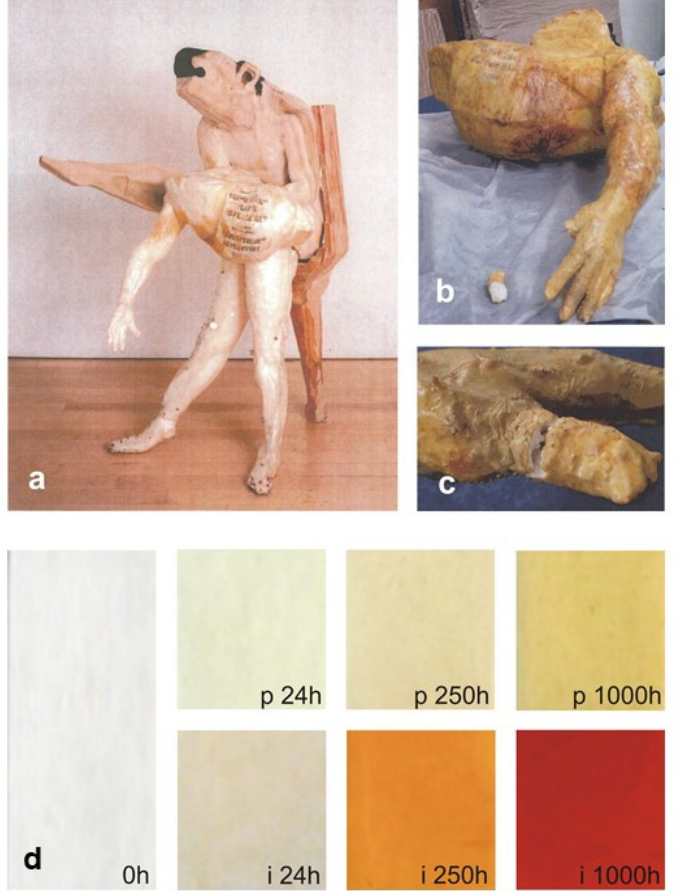
Figure 13. Comparison between “Nemeas Lion” (1998) by F. Leiro ( a ), pictures taken in 2012 of part of the human body ( b ) and a detail of the hand ( c ), and artificially aged reference epoxy vinyl ester films ( d ) before (labelled as 0h) and after 24, 250 and 1000 h of photodegradation (p24h, p250h and p1000h) or isothermal (i24h, i250h and i1000h) treatments. Image reprinted with permission from [27].